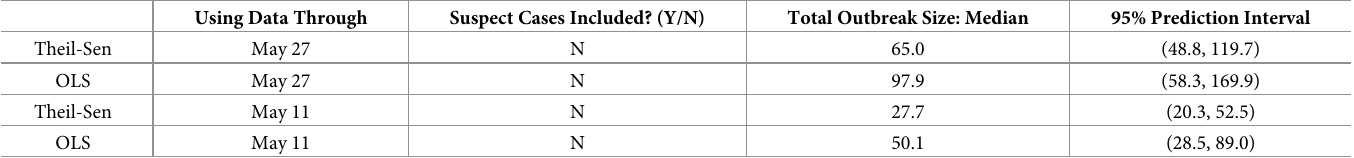
Table 3. Distribution of outbreak projections from regression model. Median and 95% prediction interval of outbreak size, by date from which cases are predicted, and by regression method, using probable and confirmed cases. Method 1: Theil-Sen regression with a pseudo-log transformation. Method 2: Ordinary Least Squares (OLS) Regression without transformation.